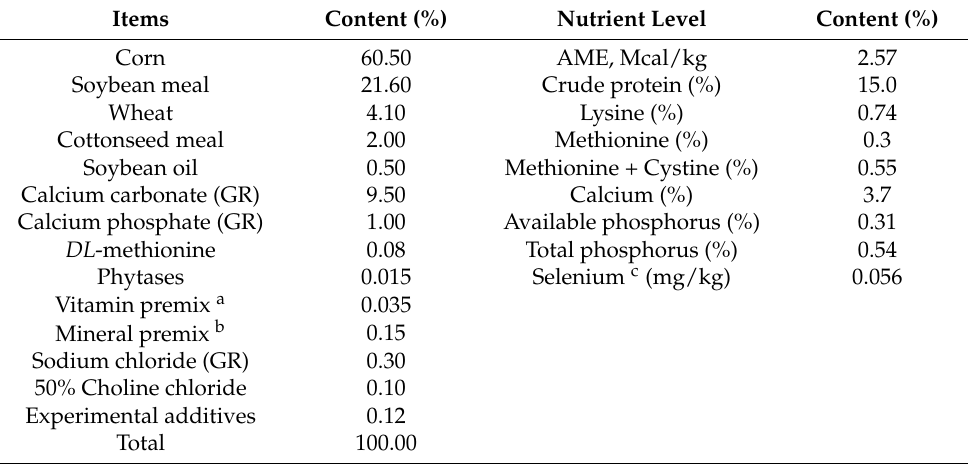
Table 1. Composition and nutrient of the basal diet.